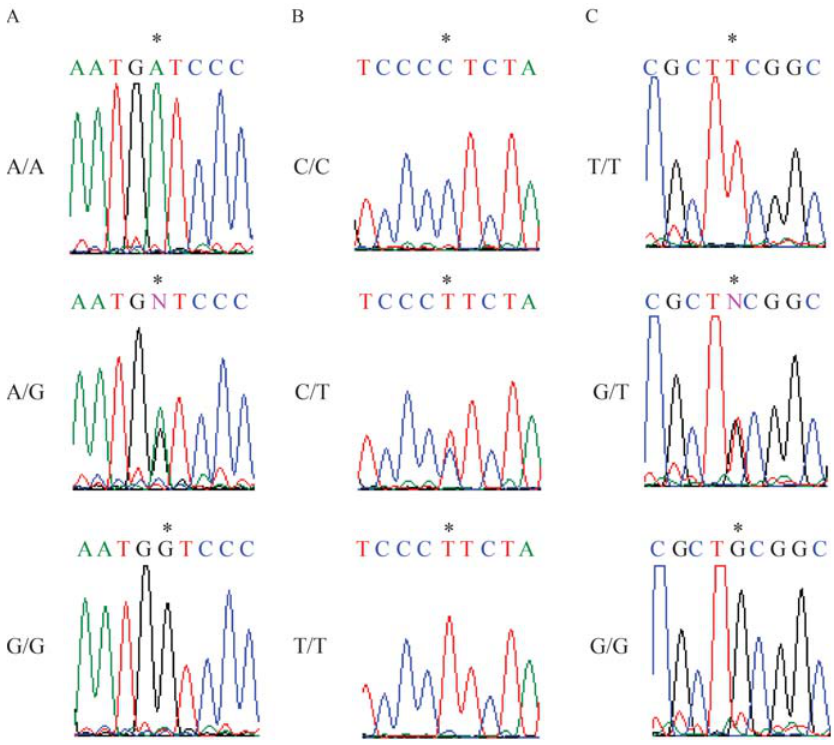
Figure 1 - Promoter polymorphisms of MDM2 at positions -628, -466, and -215. (A-C) Genomic DNA was amplified by PCR with a forward primer at positions -725 to -704 and a reverse primer at +96 to +75 of the MDM2 gene, and nucleotide sequences were determined by directly sequencing the PCR products. These sequencing reactions were performed using primers at positions -725 to -704 and -310 to -289. (*) shows nucleotides at positions -628 (A),-466(B),and-215(C)inthe MDM2 promoters,where“N”indicatesheterozygousnucleotides.Nucleotidesaroundthesepositions(*)areindicated.